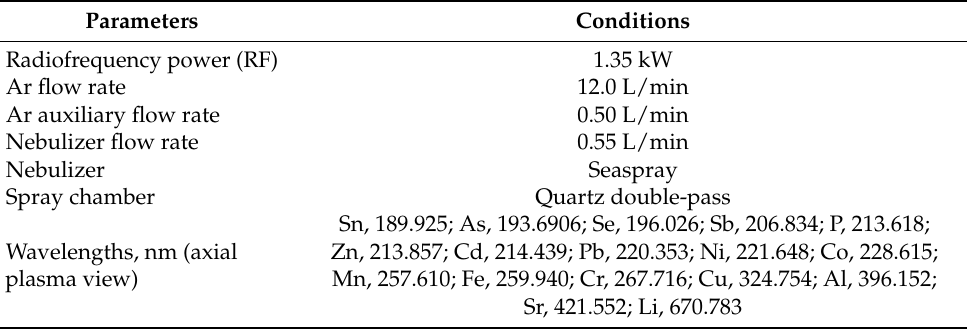
Table 2. ICP OES conditions for trace elements